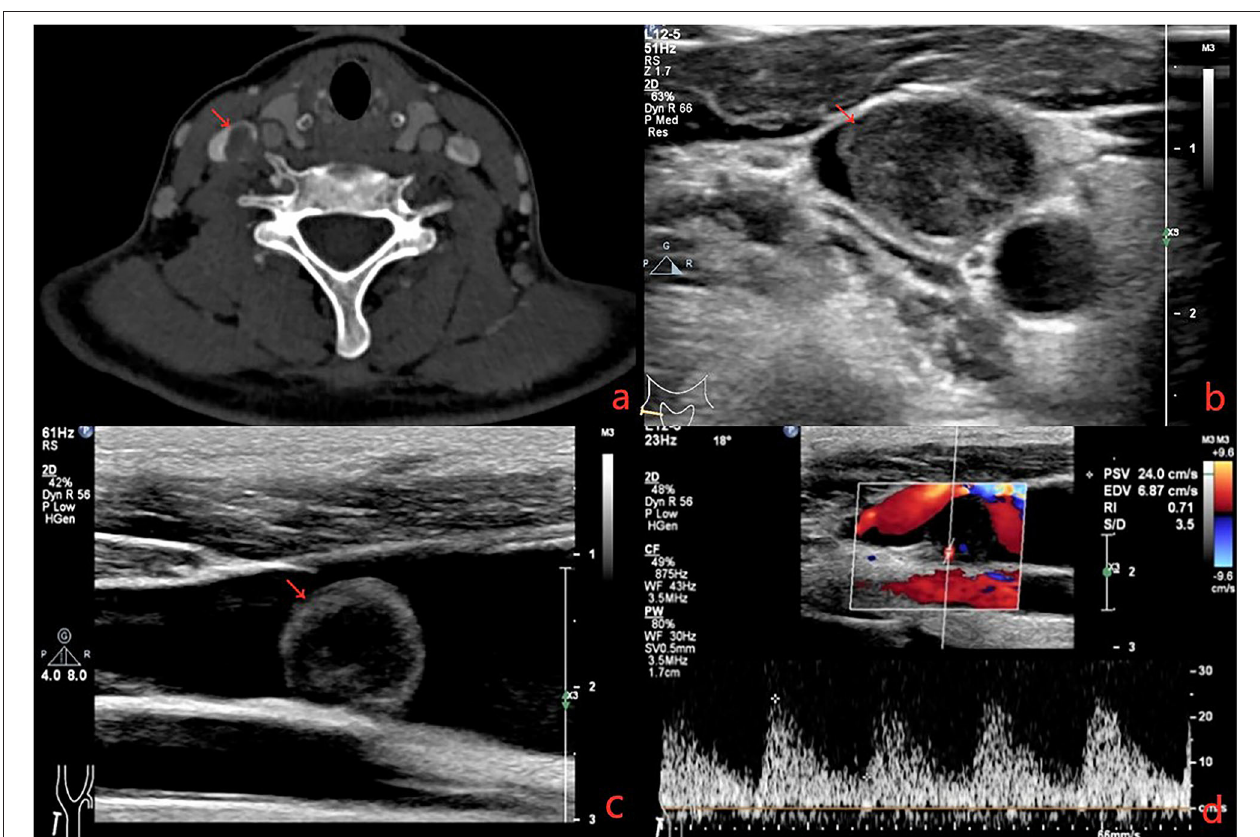
FIGURE 1 | (a) Computerized tomography shows a solid, non-enhanced nodule in the right internal jugular vein (RJV) (red arrow: nodule, green arrow: RJV). (b) Ultrasound shows the nodule arising from the RJV without extravascular invasion (red arrow: nodule, green arrow: RJV). (c) Ultrasound shows the nodule led to severe RJV stenosis (red arrow: nodule, green arrow: RJV, red triangle: right internal carotid artery). (d) Doppler ultrasound detected the blood flow signals in the nodule.